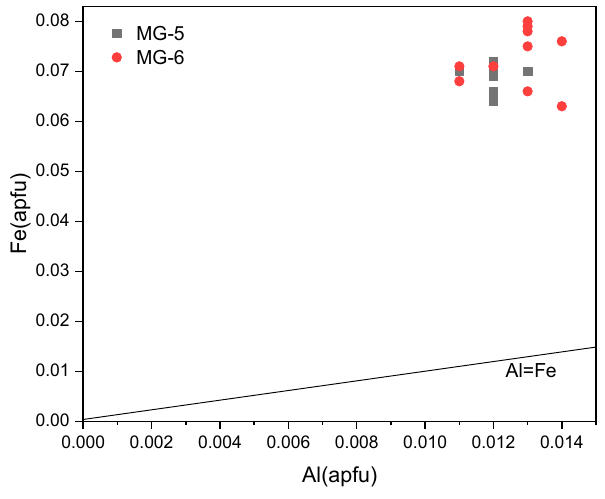
Figure 15. Fe vs. Al cations per formula unit.